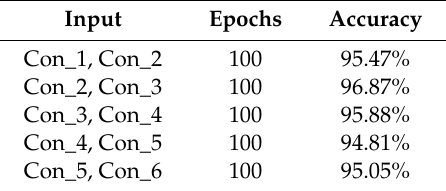
Table 4. Comparison between SSE Module at di ff erent locations.